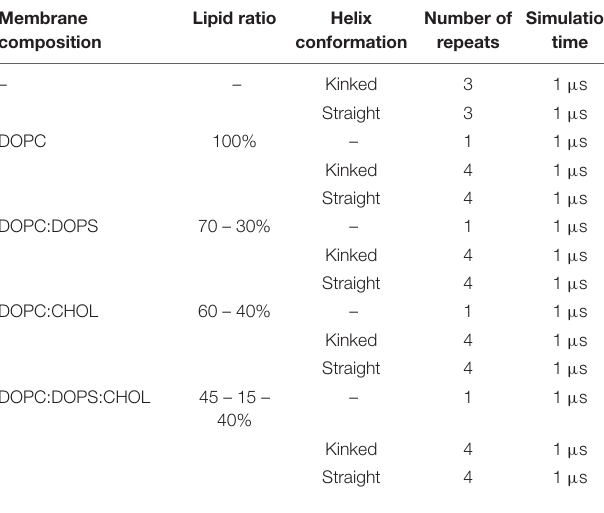
TABLE 1 | Simulation overview of atomistic simulations with various membrane composition including DOPC, DOPS, and CHOL. Membrane Lipid composition